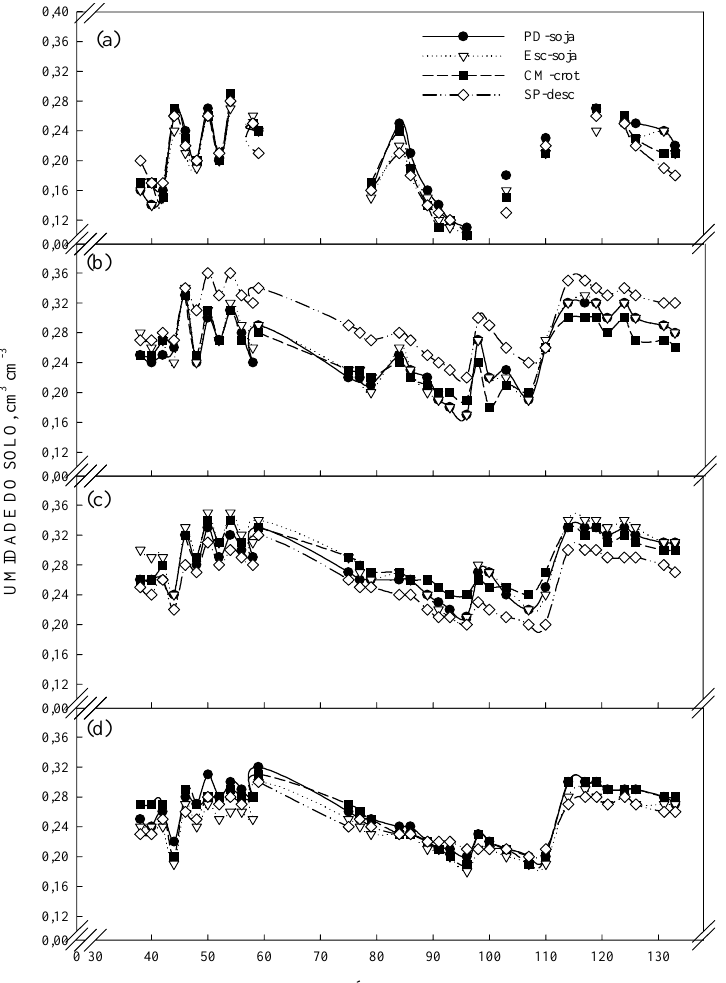
Figura 6. Variação da umidade volumétrica do solo para as profundidades de 0 a 0,10 m (a); 0,10 a 0,27 m (b); 0,27 a 0,43 m (c) e 0,43 a 0,60 m (d).